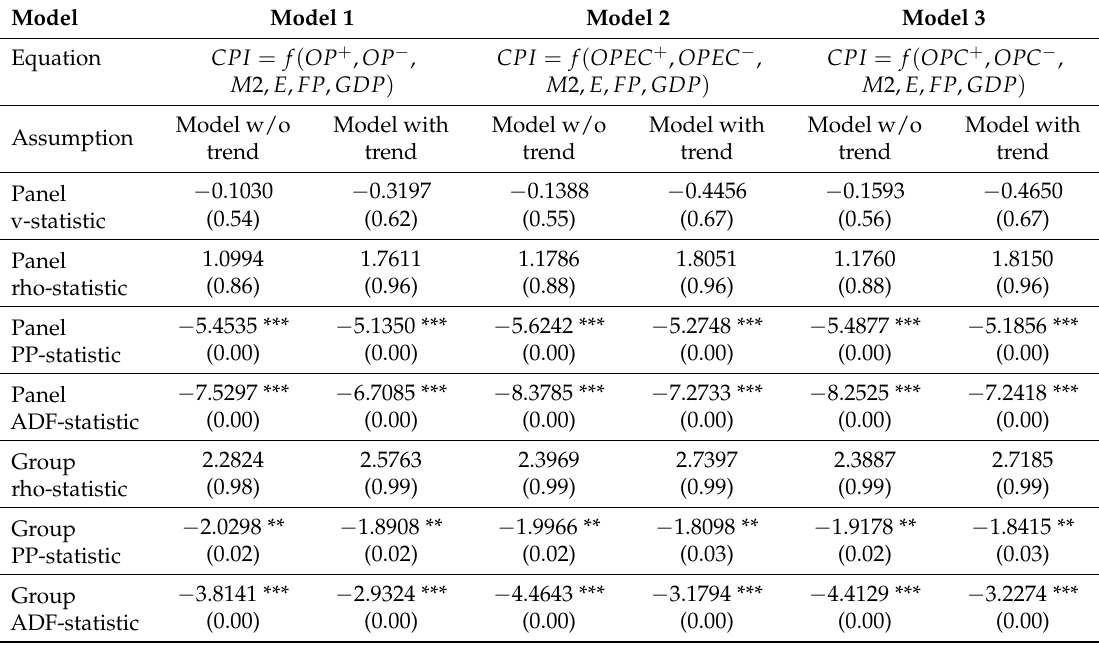
Table 3. Nonlinear panel cointegration test